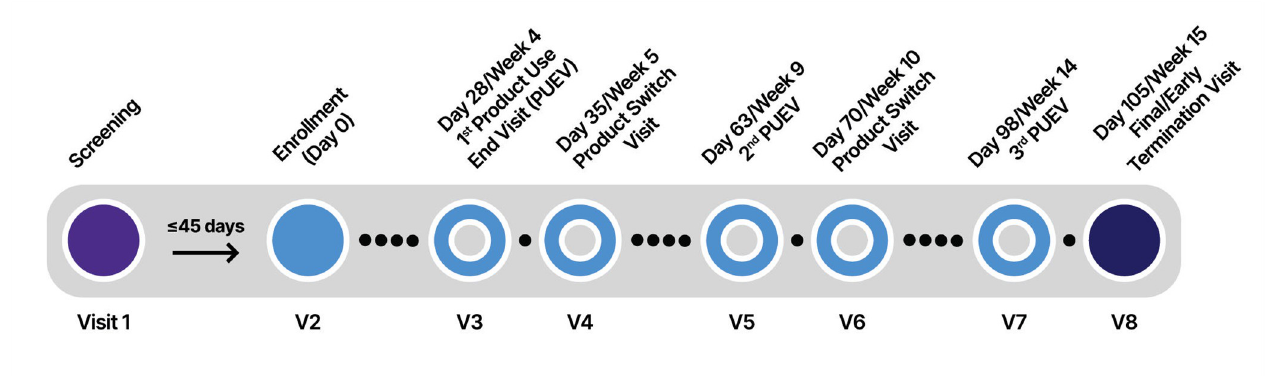
Fig 3. MTN-035 study